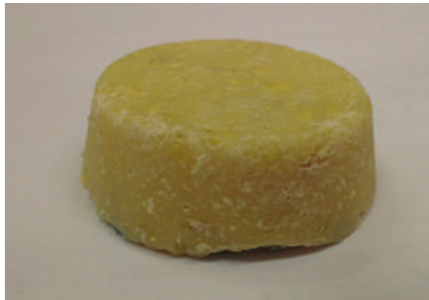
Table 1: Summary of variables for the mixture design.